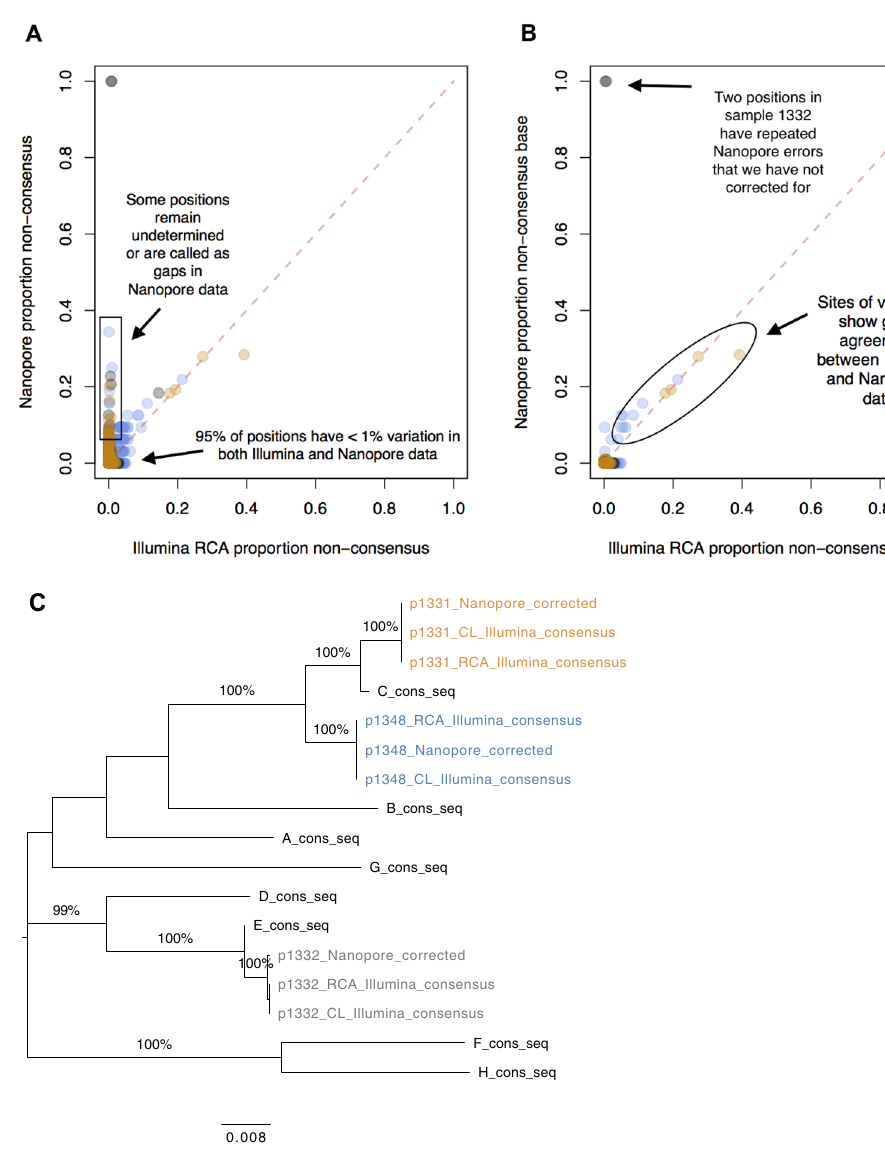
Figure 5. Comparison of HBV sequence data generated by Nanopore vs Illumina platforms, using completion/ ligation (CL) and rolling circle amplification (RCA). ( A ) Proportion of non-consensus calls at each position in the genome based on Nanopore (y-axis) vs Illumina (x-axis), for samples 1331 (orange), 1332 (grey) and 1348 (blue). Note that the ‘proportion of non-consensus calls’ represents a slightly different quantity in the two data sets: in the Illumina data, an individual concatemer may give rise to multiple reads covering a position, where as in the Nanopore data each concatemer results in only one base call. The two sites with 100% variation